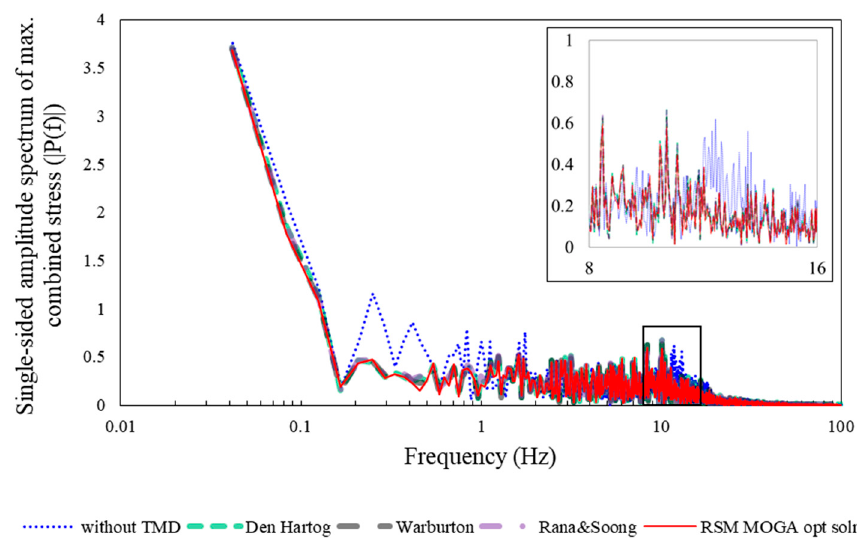
Figure 13. Comparison of the FFT frequency responses of the maximum combined normal stresses of the overall piping system. Table 6. Comparison of the maximum spectral response ratios according to whether TMDs were installed and the difference between the optimal design formula/methods.